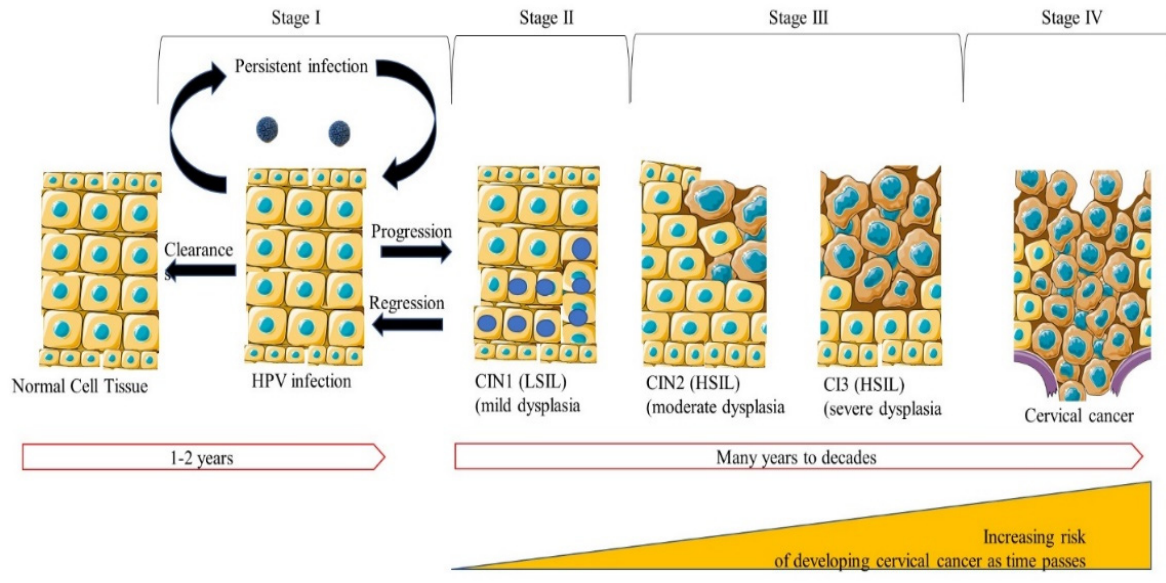
Figure 2. HPV-mediated carcinogenesis in cervical cancer. Infection with HPV mainly occurs in the cervical epithelium's basal layer, which is exposed through abrasion. Infections are cleared by the immune system in 1–2 years; however, persistent infection results in the progression of infection. During the early stages of infection, early genes are expressed (E1, E2, E4, E5, E6, and E7), and viral replication occurs. The late genes encoding for late and viral encapsulated proteins are expressed, and the assembling of viral particles occurs. Lesions may progress to HSIL; however, this happens in a minority of women. If left untreated, HSIL usually leads to cervical cancer.